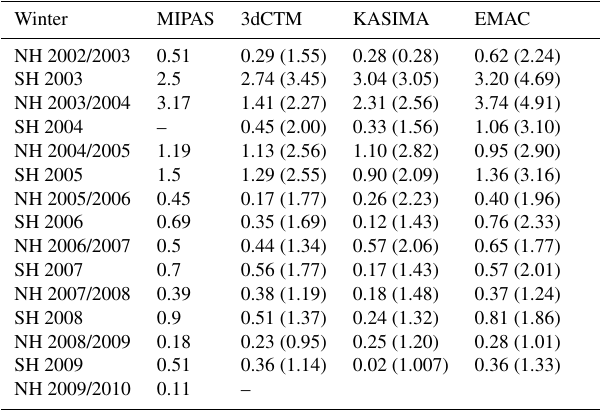
Table 2. Comparison of modeled EPP NO y (Gmol) with data de- rived from MIPAS (Funke et al., 2014b). For the models, the dif- ference between the highest value of this winter minus the lowest value of the preceding summer is given; in brackets, the maximal value of the winter is